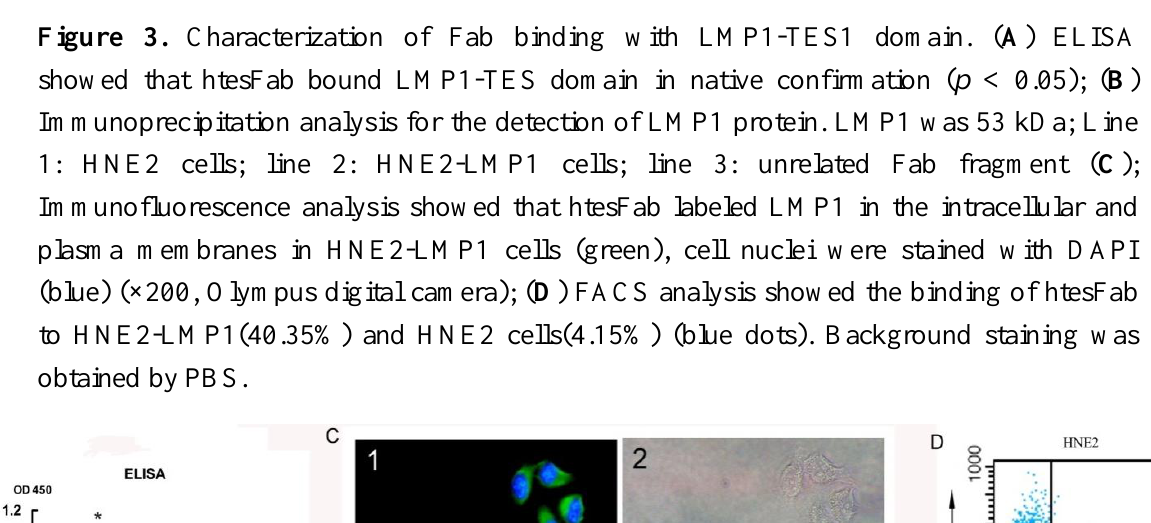
Figure 3. Characterization of Fab binding with LMP1-TES1 domain. ( A ) ELISA showed that htesFab bound LMP1-TES domain in native confirmation ( p < 0.05); ( B ) Immunoprecipitation analysis for the detection of LMP1 protein. LMP1 was 53 kDa;